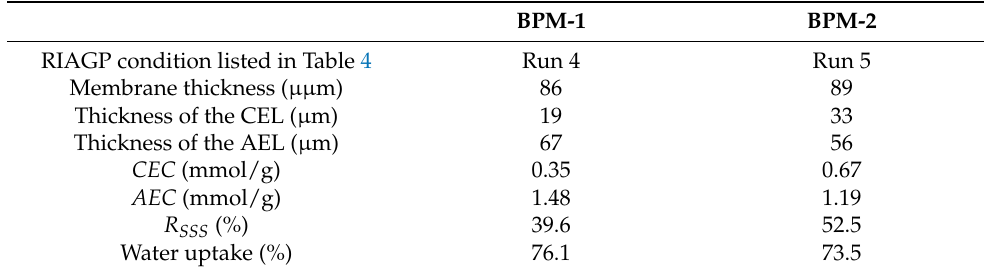
Table 5. Properties of the prepared